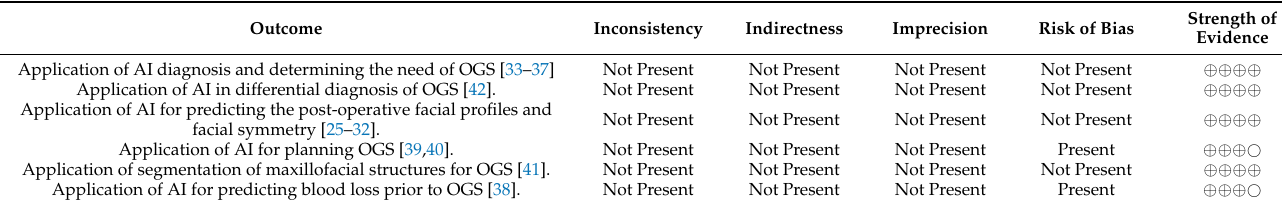
Table 3. Assessment of Strength of